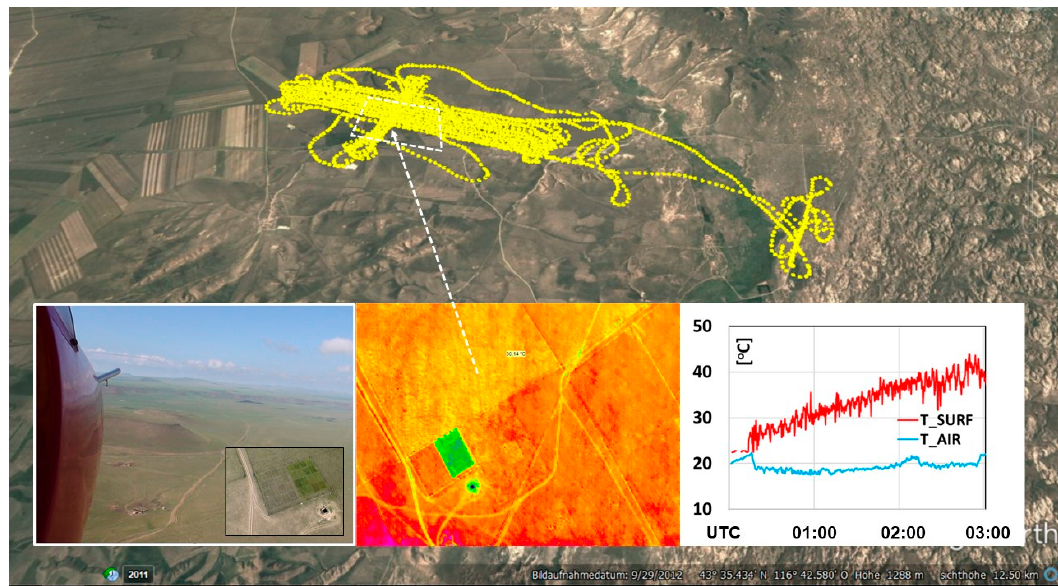
Figure 10. Flight over a grassland observation area in Inner Mongolia, China, for surface temperature measurements. The change of the surface temperature with the incoming shortwave radiation is proposed to be an indicator of soil water content. Flight altitude 500 m above ground level (agl) over complex terrain in partially volcanic environment. High resolution (640 × 480) thermography (center panel) shows spatial variability in surface temperature and dependence on vegetation cover. Right panel shows the 3h surface temperature (T_SURF) trend and temperature at flight elevation (T_AIR).